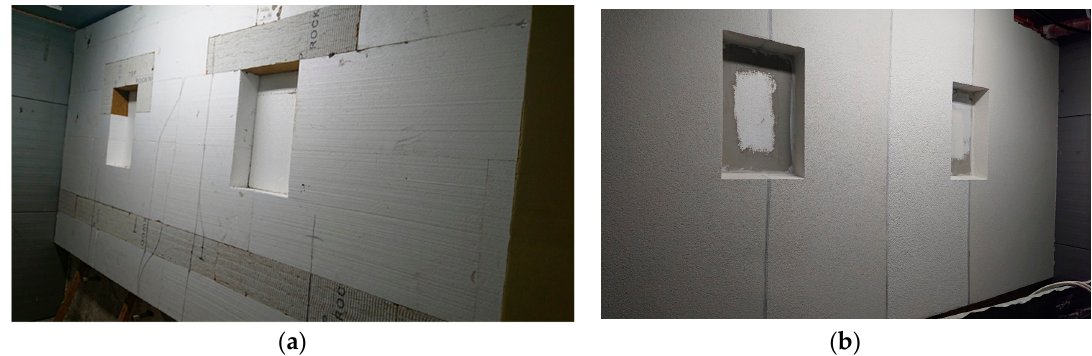
Figure 1. ( a ) EPS thermal insulation with mineral wool fire barriers; ( b ) test rig with 4 types of